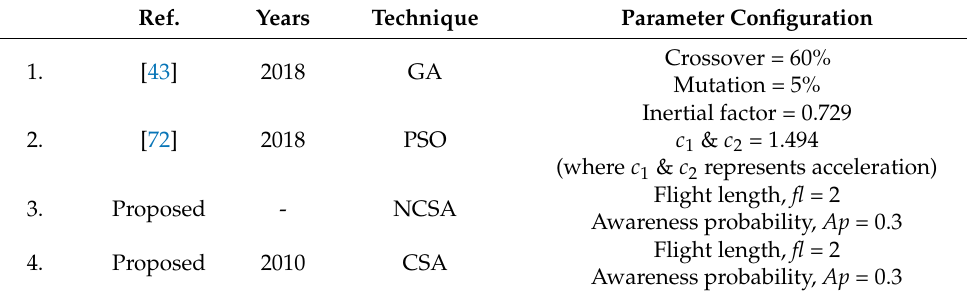
Table 4. Parameters used for metaheuristic algorithms on well placement optimization. Ref.